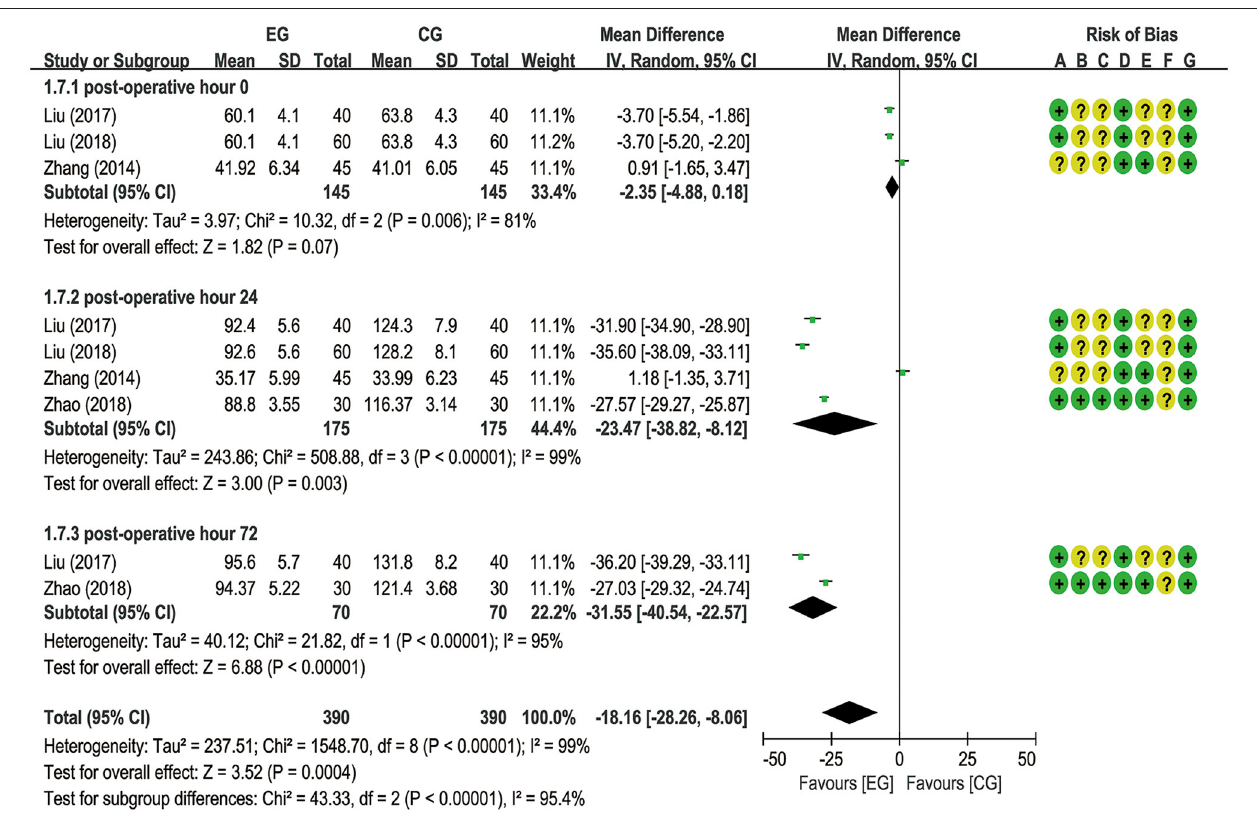
FIGURE 8 | Meta-analysis and forest plot and for tumor necrosis factor- α (TNF- α ) at different